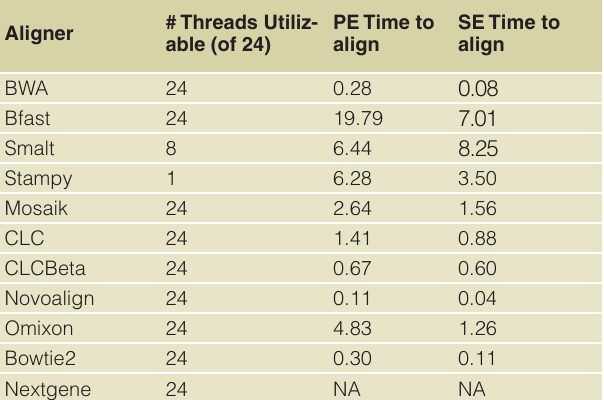
Table 2. Aligner run times in wall-clock hours. Each aligner was tested by aligning all 67 groups of simulated Illumina reads in single and paired-end mode. The maximum number of threads utilizable by each aligner were used in testing.